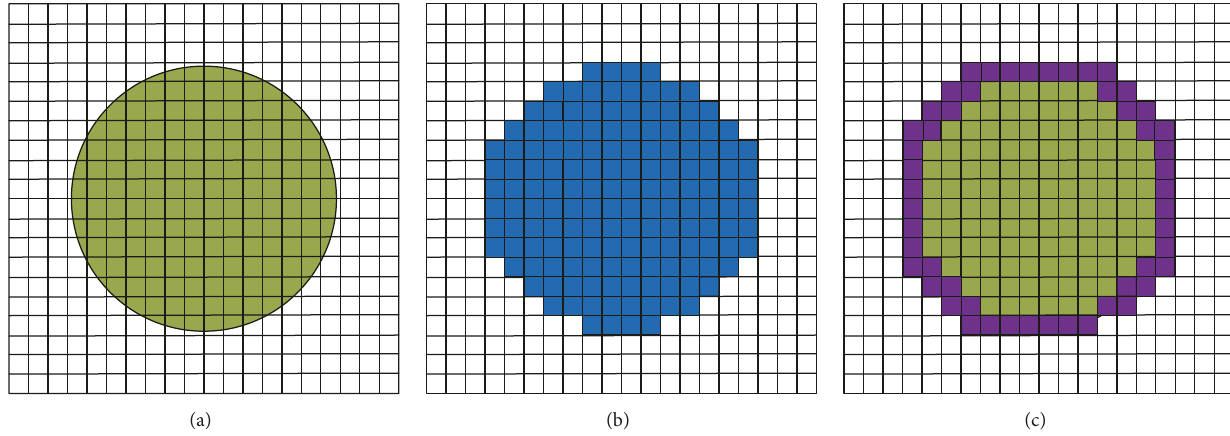
Figure 3: Schematic view for the subdivisions of a circle. (a) An actual model for a circle. (b) The subdivision diagram using the conventional ladder approximation. (c) The conformal grid for a circle.